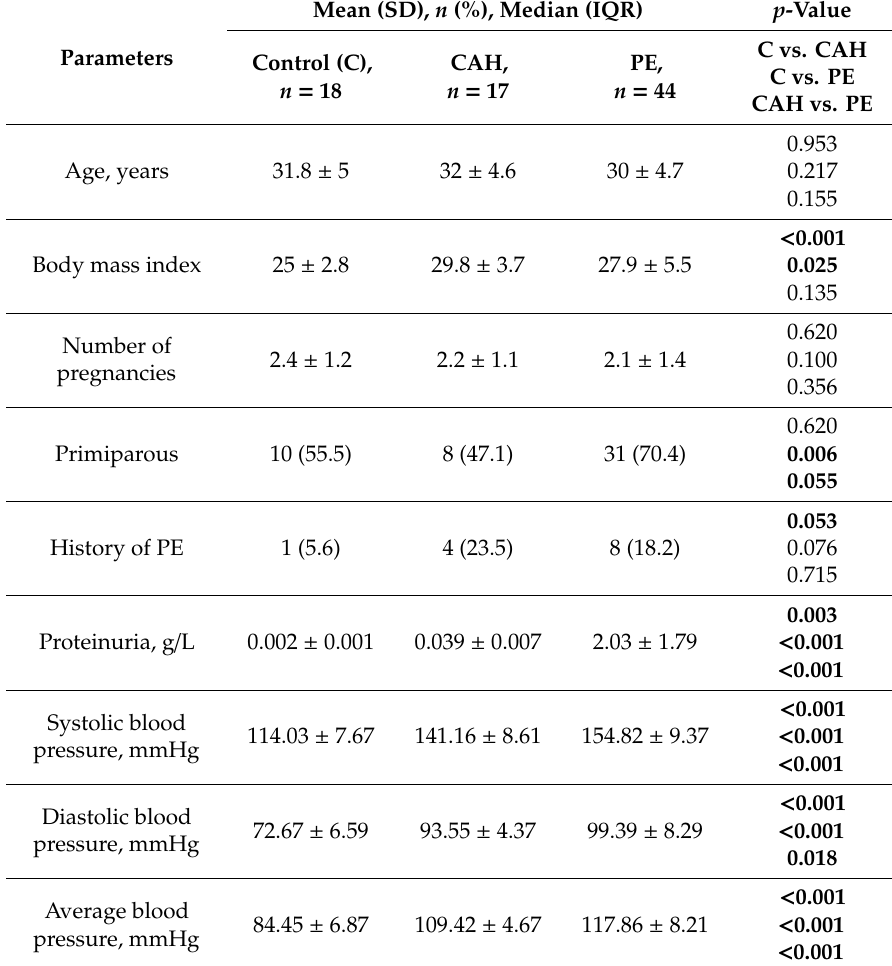
Table 1. Demographic and clinical data of the patients ( p -values less than 0.05 are in bold).